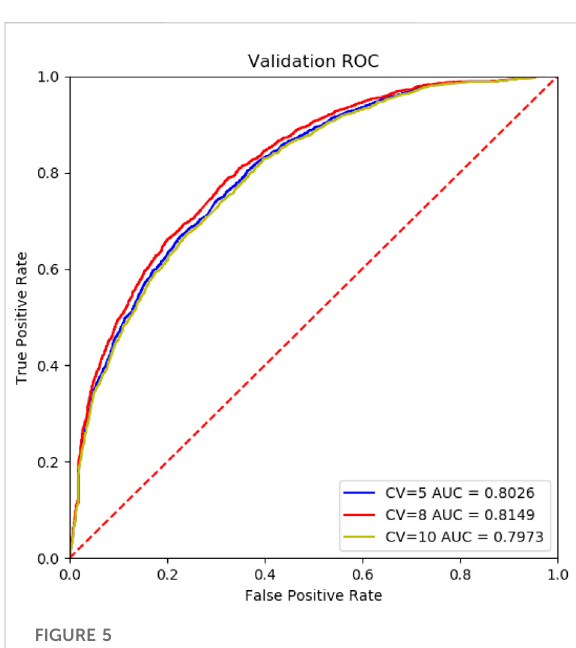
FIGURE 5 The comparision ROC curves of 5-,8-,10-fold cross- validation oftheDeep_KsuccSite onthetraining data set.Blue, red and yellow curves indicated the ROC curves of 5-,8-,10-fold cross-validation, which had AUCs of 0.8026, 0.8149, and 0.7973,